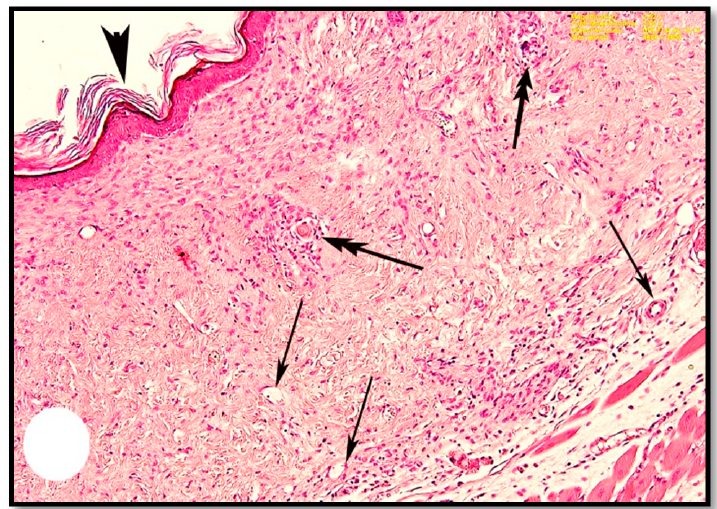
Figure 7. Photomicrographs of sections of burnt wounds in the mice skin treated with 1% SSD and protease enzyme. Showing nearly normal regenerated epidermis (arrowhead) and dermis with newly formed granulated follicles (double arrows) and rich with blood vessels (arrows). (H & E, Magnification: 2.52×).